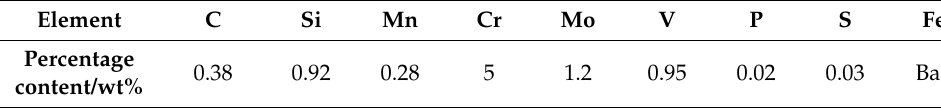
Figure 2. Planar continuous heat source model. Table 1. Chemical composition of H13 steel.